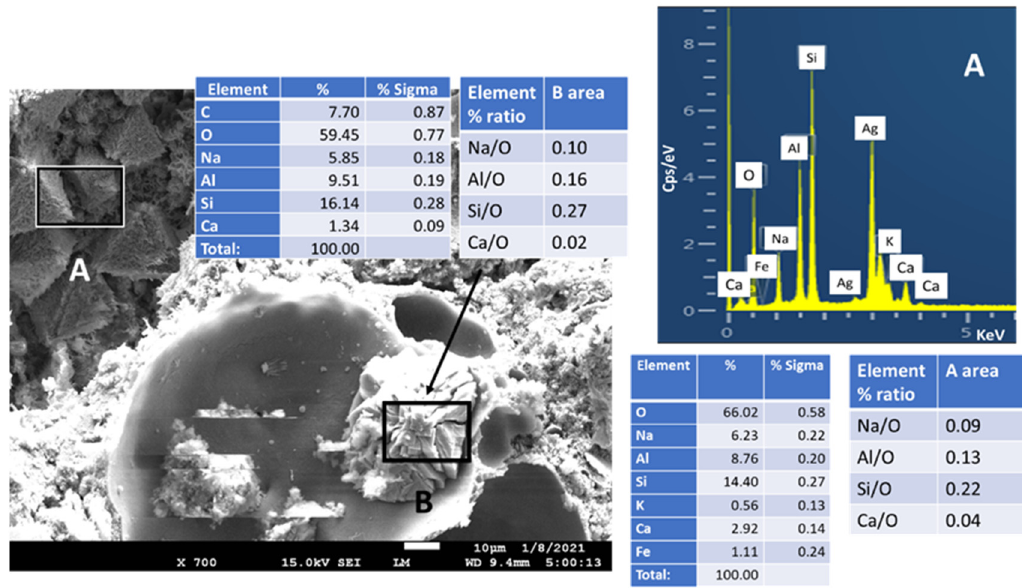
Figure 28. SEM image and EDX elemental composition of CAC blend with 3% PMHS-treated FCSs after autoclaving for 24 h at 250 °C.